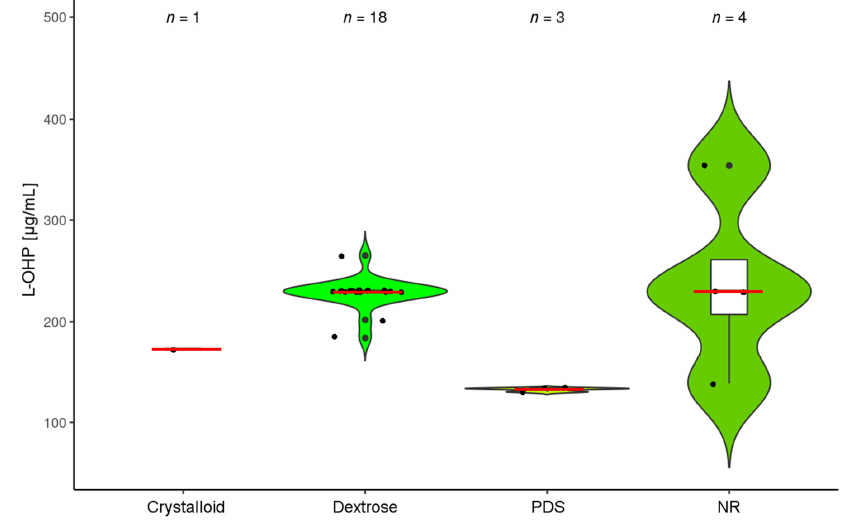
Figure 7. Drug concentration of L-OHP: The violin plot depicts concentrations of L-OHP, as used in different HIPEC protocols. Protocols were categorized according to the matrix used to dilute drugs (crystalloid, dextrose, PDS or NR). Since there is lacking uniformity and for comparative reasons, we imputed data to a presumed average patient (with characteristics of 1.7 m height, 70 kg weight and 1.73 m 2 body surface area). Further, in case of ambiguity values were maximized using the maximal drug amounts and the minimum diluent volumes reported. The red bars mark medians and white boxes interquartile range. Protocols with missing data or reporting ≤4 patients and the outlier [121] were omitted. (Median drug concentrations (µg/mL): crystalloid: 173; Dextrose: 230; PDS: 133; NR: 230). Abbreviations used: L-OHP (oxaliplatin); PDS (peritoneal dialysis solution); and NR (not reported).